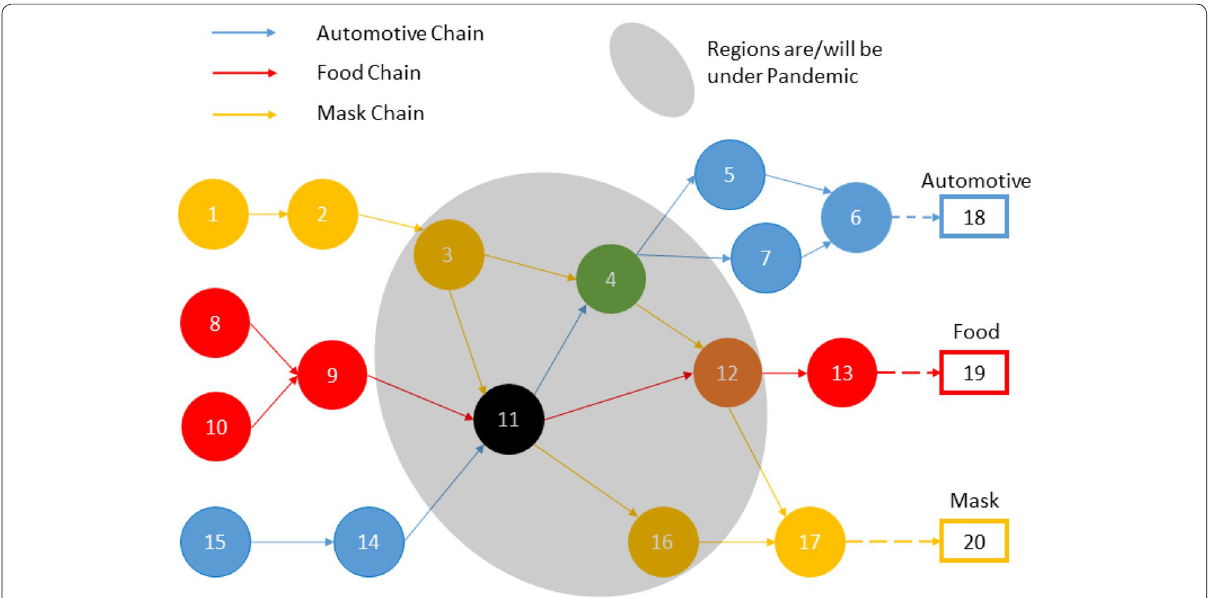
Figure 2 Hypothetical IIoT-based industrial network under a